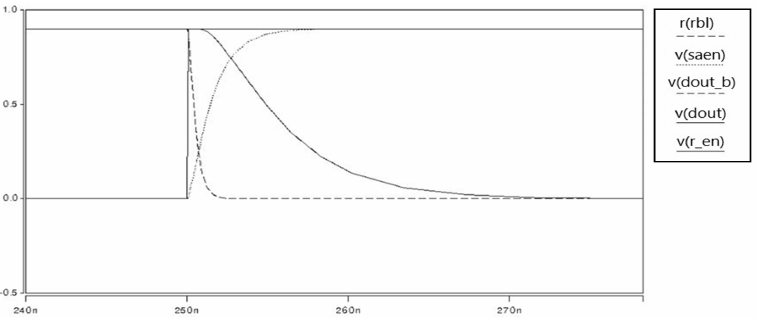
Figure 26. Waveform of Reading 0 operations in CNFET.